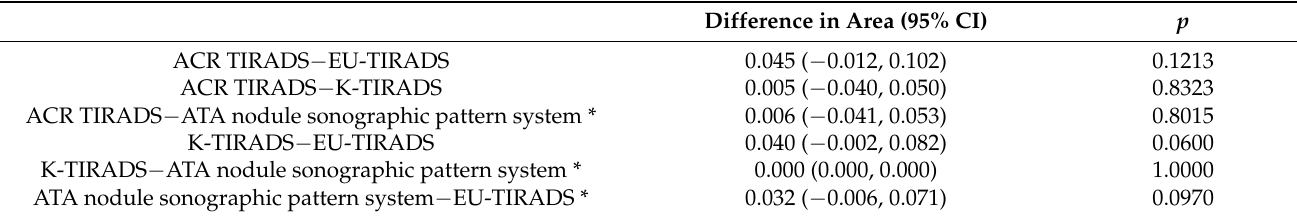
Table 6. Pairwise comparison of the area under the receiver operating characteristic curve of ultrasonography-based risk stratification systems to predict thyroid malignancy in nodules with nondiagnostic or unsatisfactory cytopathological